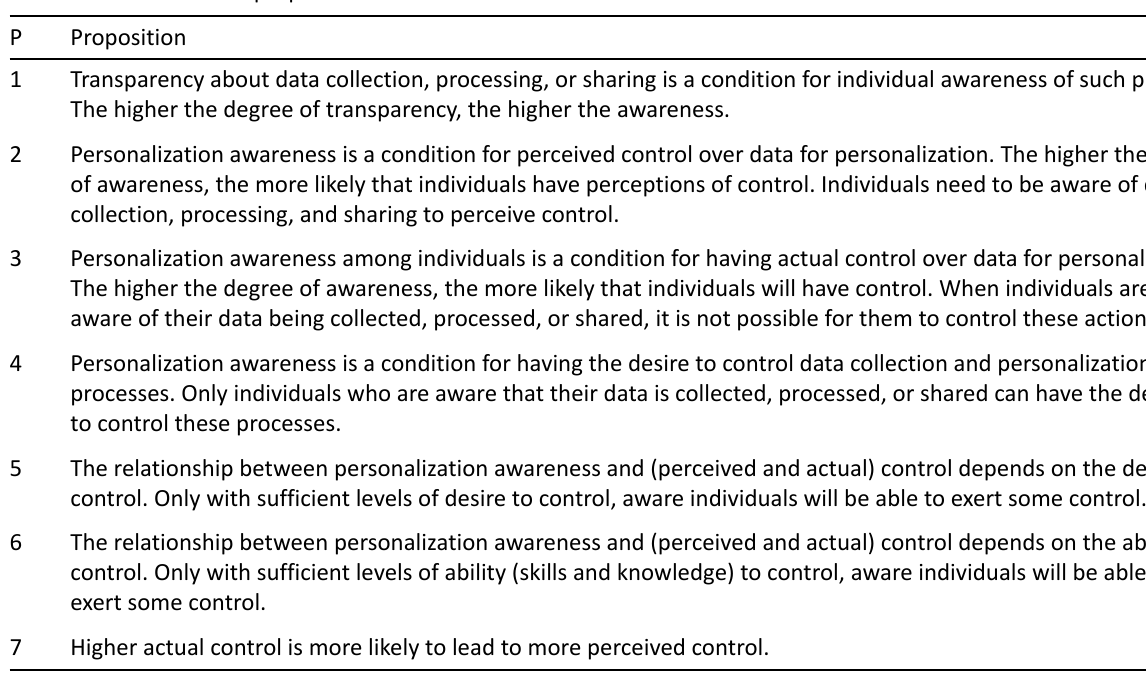
Table 3. TAC framework